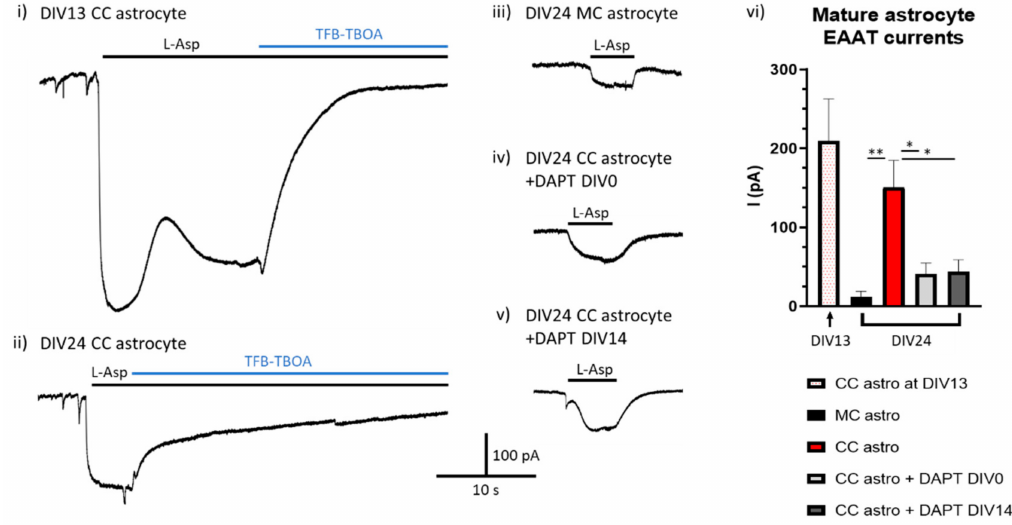
Figure 3. Notch signalling is needed to maintain astrocytic EAAT function. Example traces of EAAT mediated currents in response to 200 µ M L-Asp in ( i ) DIV13 neuronal cocultured (CC) astrocyte, ( ii ) DIV24 CC astrocyte, ( iii ) DIV24 monocultured (MC) astrocyte, ( iv ) DIV24 CC astrocyte + DAPT from DIV0, and ( v ) DIV24 astrocyte + DAPT from DIV14. Cells were voltage-clamped at − 80 mV and all recordings were done in the presence of 100 µ M AP-5. ( vi ) At DIV24 there was a significantly larger EAAT mediated response in control CC astrocytes compared to MC astrocytes ( p = 0.009, LME ANOVE, df = 29), as well as CC astrocytes treated with DAPT from either DIV0 or DIV14 ( p = 0.028 & 0.027, for DIV0 and DIV14 respectively, LME ANOVA, df = 29). There was no di ff erence in EAAT response in CC astrocytes treated with DAPT from DIV0 or from DIV14 after currents had been established. Recordings were taken from cells across at least three independent culture batches. * p < 0.05, ** p <